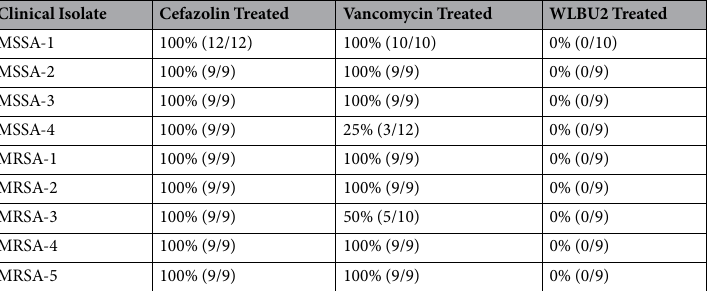
Table 1. 72-hour culture test from panel of methicillin sensitive and resistant S. aureus clinical isolate biofilms after 24 hours of treatment with cefazolin or WLBU2 at 10x MIC. Each strain repeated at least three separate times in